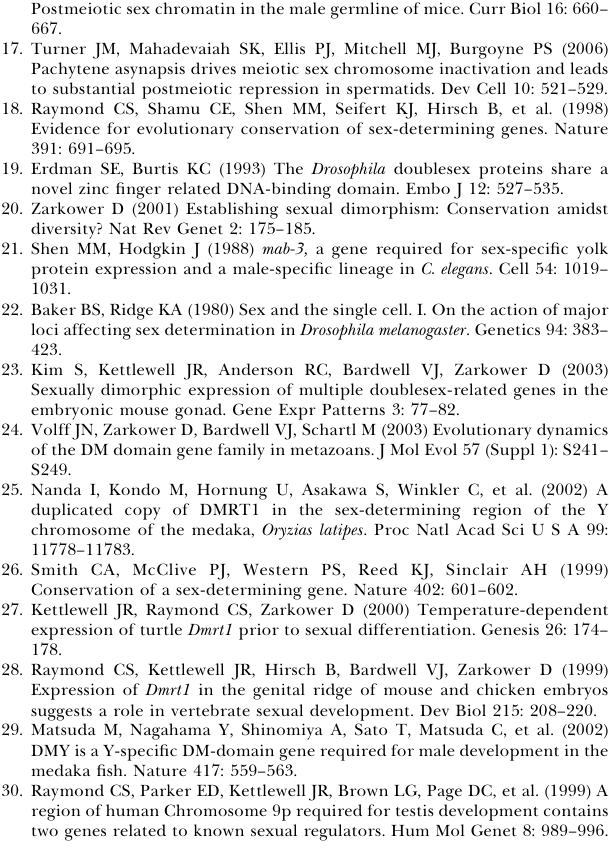
Figure S3. Normal Androgen Receptor Expression in Dmrt7 Mutant Sertoli Cells Testis sections from adult mice stained with antibody to androgen receptor (red) and counterstained with DAPI (blue). In both wild-type (top) and mutant (bottom) testis sections, androgen receptor protein is expressed in Sertoli cell and peritubular myoid cell. Mutant testis section shows abnormal localization of Sertoli cell nuclei, which are displaced from basement membrane. AR, androgen receptor. Figure S4. Ub-H2A Localization to XY Body in Dmrt7 Mutant Spermatocyte Spread pachytene spermatocytes from wild-type (top) and Dmrt7 mutant (bottom) mice, stained with antibody to Ub-H2A (green) and DAPI (blue). Arrows indicate XY body. Both wild-type and mutant pachytene cells have Ub-H2A properly localized to XY body. Found at doi:10.1371/journal.pgen.0030062.sg004 (722 KB JPG).